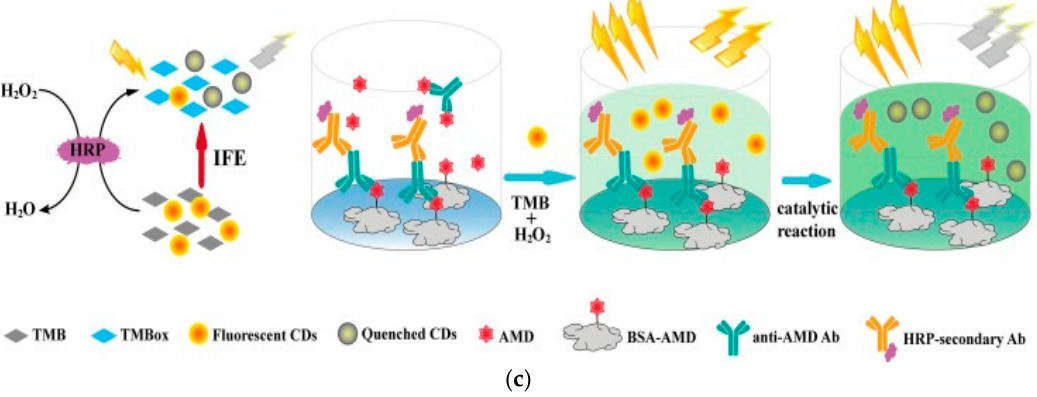
Figure 7. Application of CDs fluorescence quenching for the detection of harmful substances. ( a ) The mechanism involved in the CD fluorescence quenching for methylmercury detection. Reproduced with permission from reference [177]. Copyright 2014 American Chemical Society. ( b ) The principle of inner filter effect-based fluorescence quenching of CDs. Reproduced with permission from reference [178]. Copyright Elsevier, 2018. ( c ) Scheme of the CD-based fluorescent ELISA for amantadine detection. Reproduced with permission from reference [179]. Copyright Elsevier, 2019.